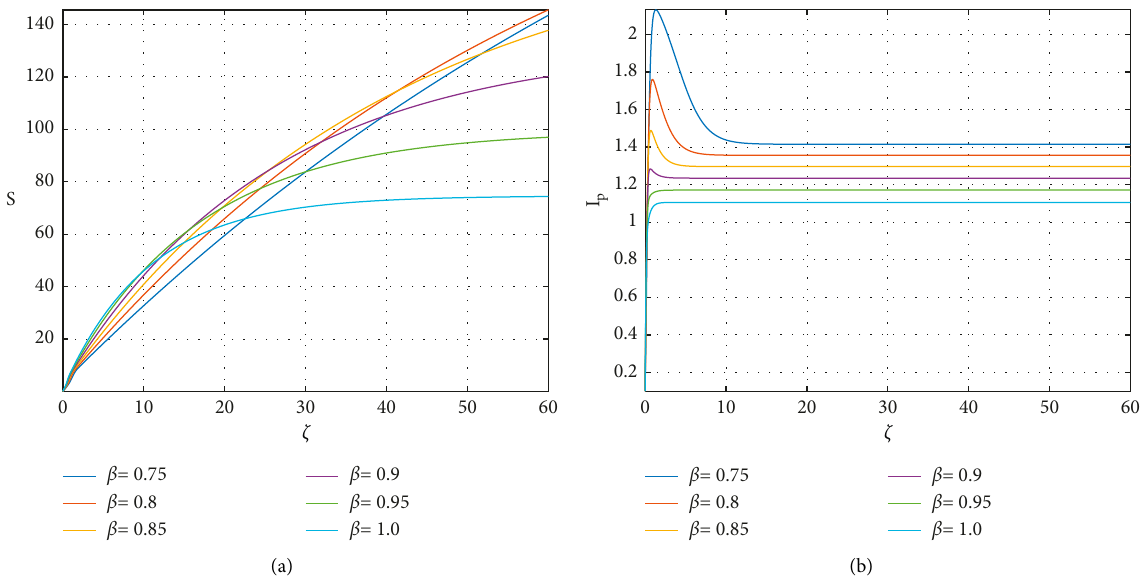
Figure 4: Two-dimensional illustration of the susceptible class S and pneumonia infectious I β ∈ [ 0 , 1 ] .